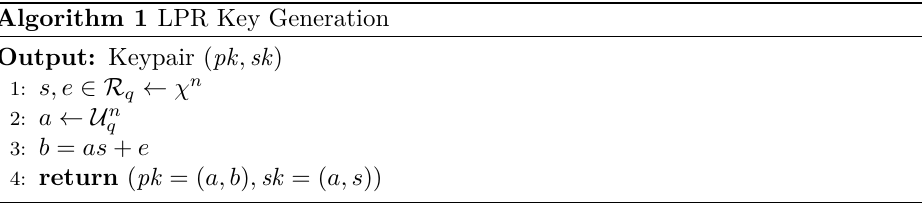
Algorithm 2 LPR